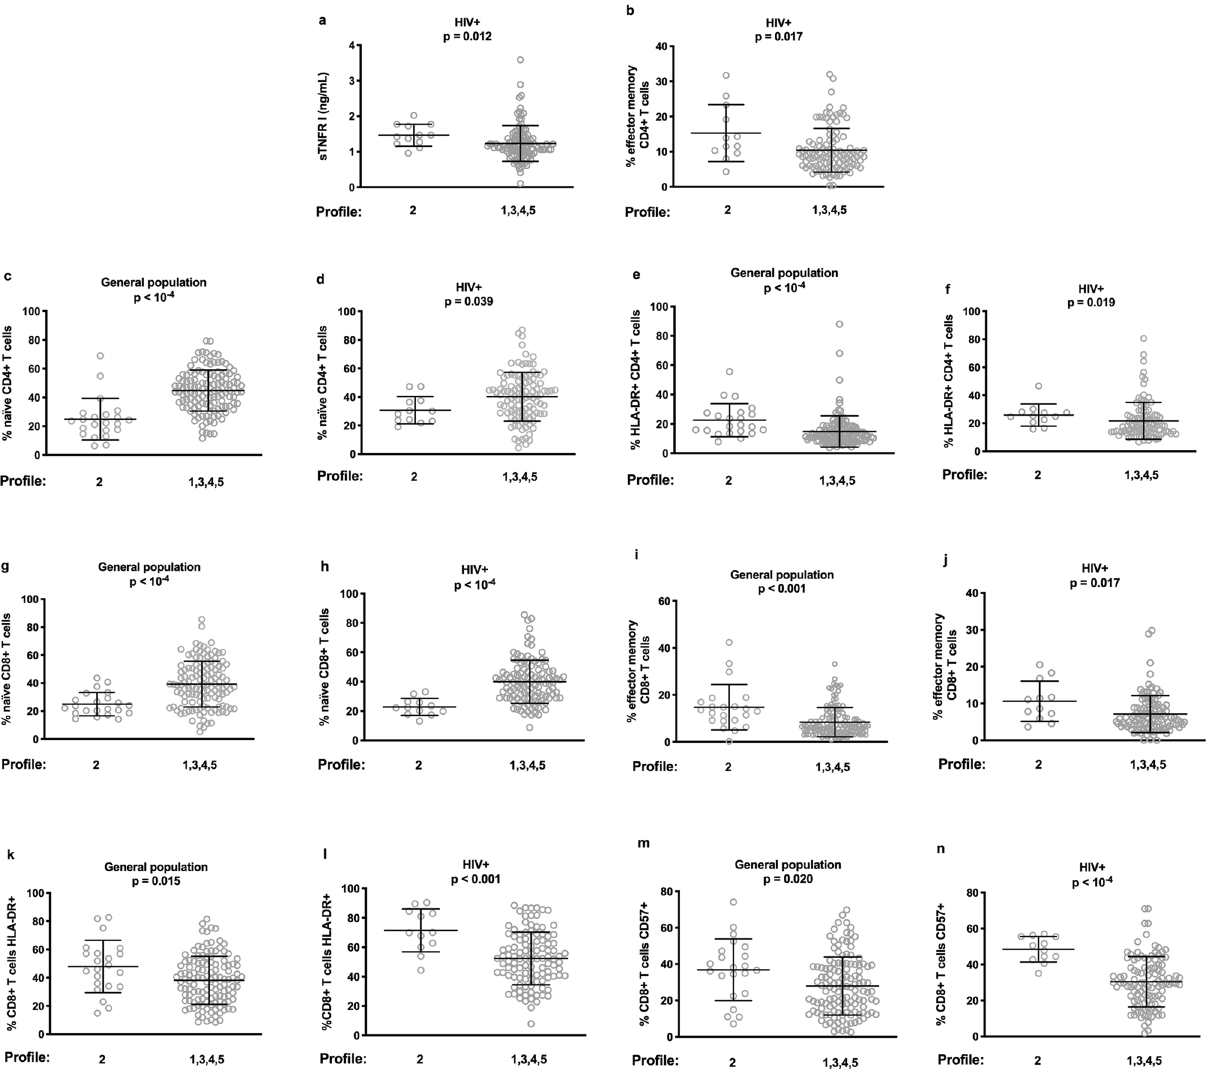
Figure 4. Common immunological characteristics between the general population Profile 2 and the HIV patients Profile 2. The expression of each marker in Profile 2 is compared with its expression in the other